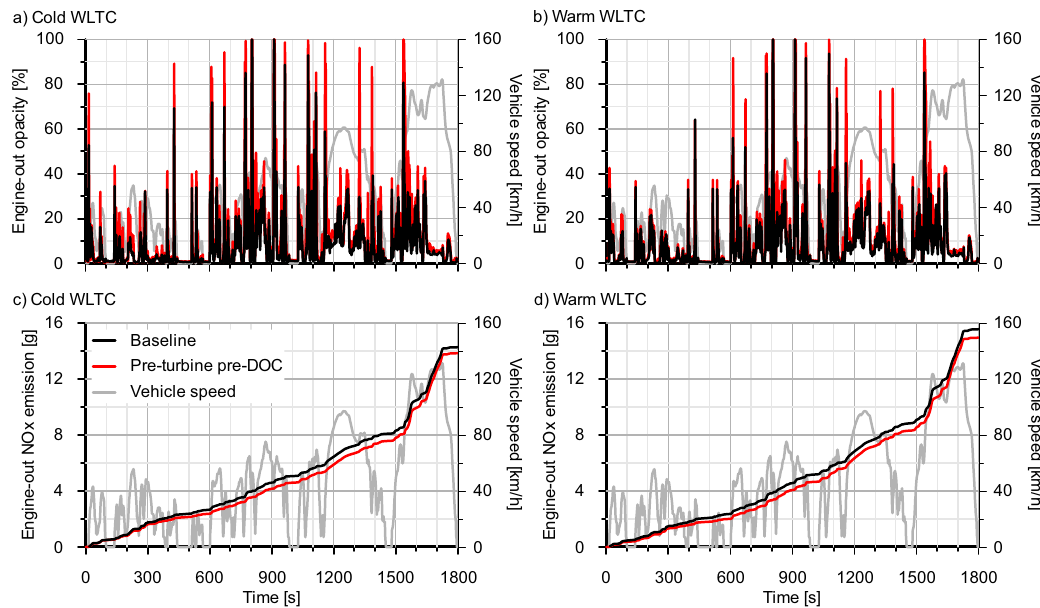
Figure 4. Engine-out opacity and cumulative NOx emission in cold and warm WLTCs with baseline ATS and pre-turbine pre-DOC configurations. ( a ) Instantaneous engine-out opacity in cold WLTC, ( b ) instantaneous engine-out opacity in warm WLTC, ( c ) cumulative engine-out NOx emission in cold WLTC, ( d ) cumulative engine-out NOx emission in warm